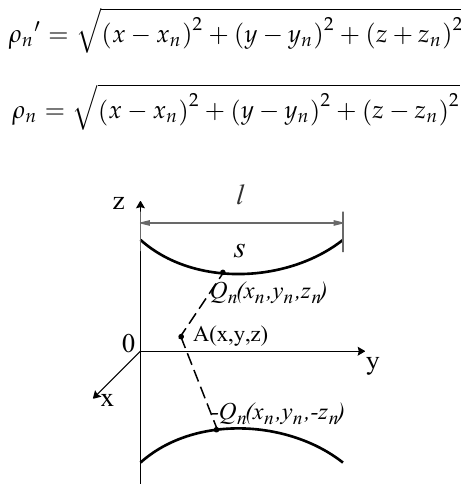
Figure 3. The 3D calculation method of finite nonlinear line